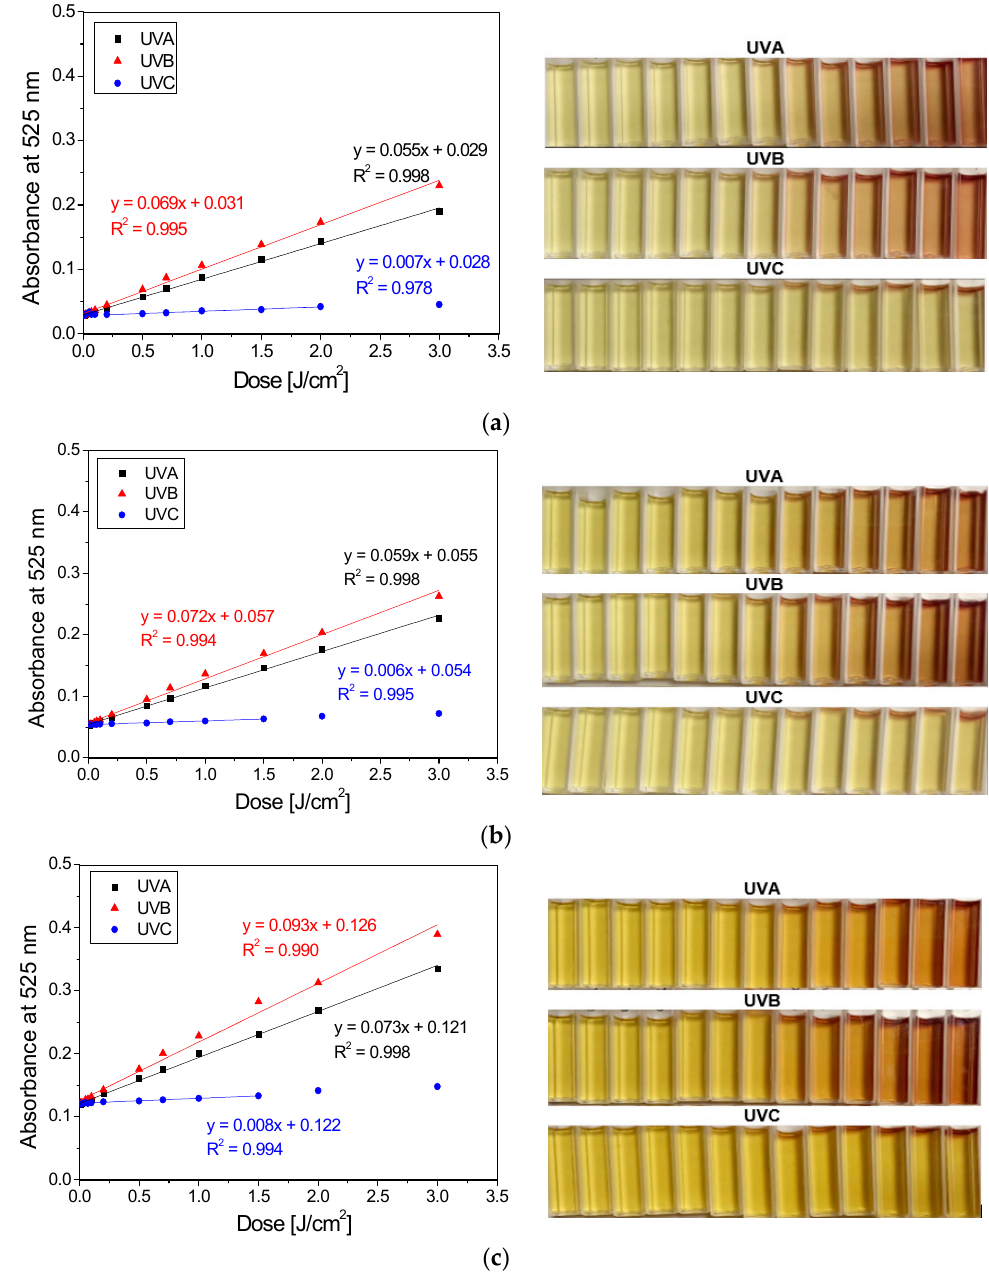
Figure 3. The dose responses of NBT-Pluronic F-127 hydrogels containing 1 g/dm 3 ( a ), 2 g/dm 3 ( b ) and 5 g/dm 3 ( c ) NBT irradiated with UVA, UVB and UVC radiation in the dose range of 0–3 J/cm 2 with corresponding photographs illustrating the samples’ colour changes after irradiation (absorbed doses: 0, 0.01, 0.02, 0.05, 0.1, 0.2, 0.5, 0.7, 1, 1.5, 2 and 3 J/cm 2 , from left to right).